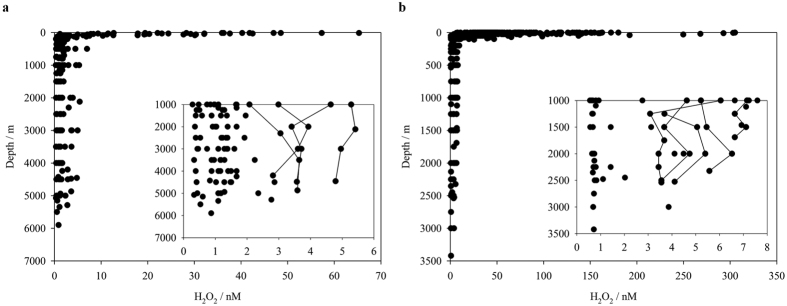
(a) H2O2 across all South Atlantic stations sampled. Only samples collected using trace metal clean Ocean Test Equipment samplers (181 data points, excluding 99 below detection limit) are shown (same data as Fig. 4b). Inset H2O2 at, or below, 1000 m (83 datapoints, excluding 80 below detection limit). For stations with multiple samples beneath 1000 m, profiles are connected if H2O2 exceeded 2.9 nM at any depth. (b) H2O2 across all Mediterranean stations. All sub-surface samples were collected from Niskin samplers free from internal metal components on a stainless steel cable (total 482 data points-including those shown in Fig. 5b, excluding 199 below detection limit). Inset H2O2 at, or below, 1000 m only (60 datapoints, excluding 64 below detection limit). For stations with multiple samples beneath 1000 m, profiles are connected if H2O2 exceeded 2.9 nM at any depth.